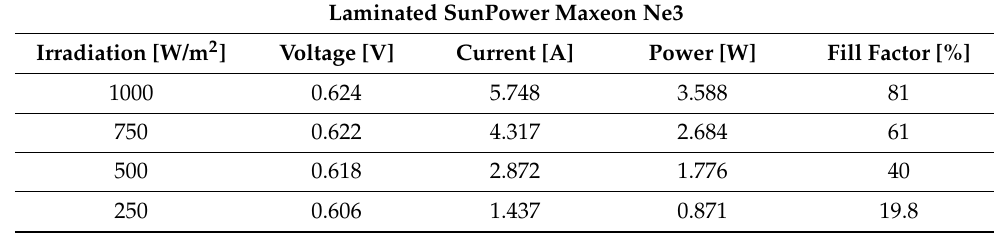
Figure 18. P-V and I-V characteristics of the laminated SunPower Maxeon Ne3 for different tem- peratures.